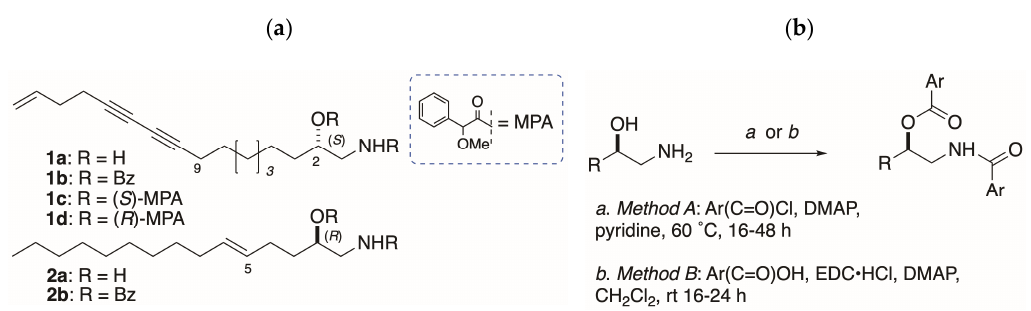
Figure 1. ( a ) Distaminolyne A ( 1a ; [7]) and un-named 1-AA natural product ( 2a ; [9]) and their corresponding acylates, 1b – d and 2b . ( b ) Two methods for acylation of 1-AAs.